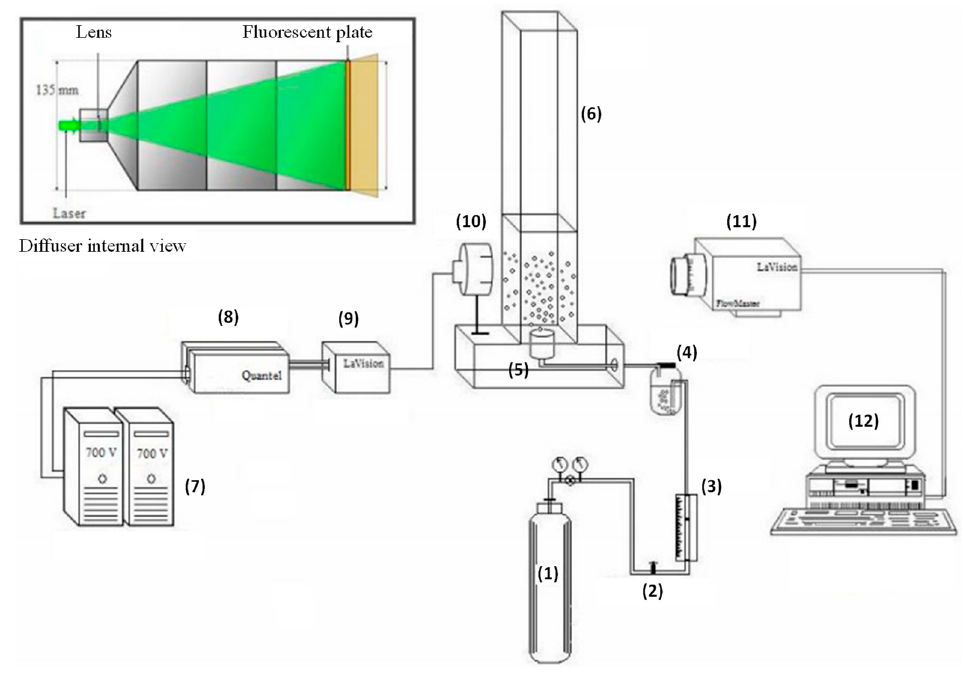
Figure 3. Experimental apparatus for determining the diameter distribution of gas bubbles. (1) Nitrogen cylinder; (2) Valve; (3) Rotameter; (4) Humidifier; (5) Gas distributor; (6) Column; (7) Power generation; (8) Laser source; (9) Collimator; (10) Diffuser; (11) CCD Camera; (12) Data acquisition.